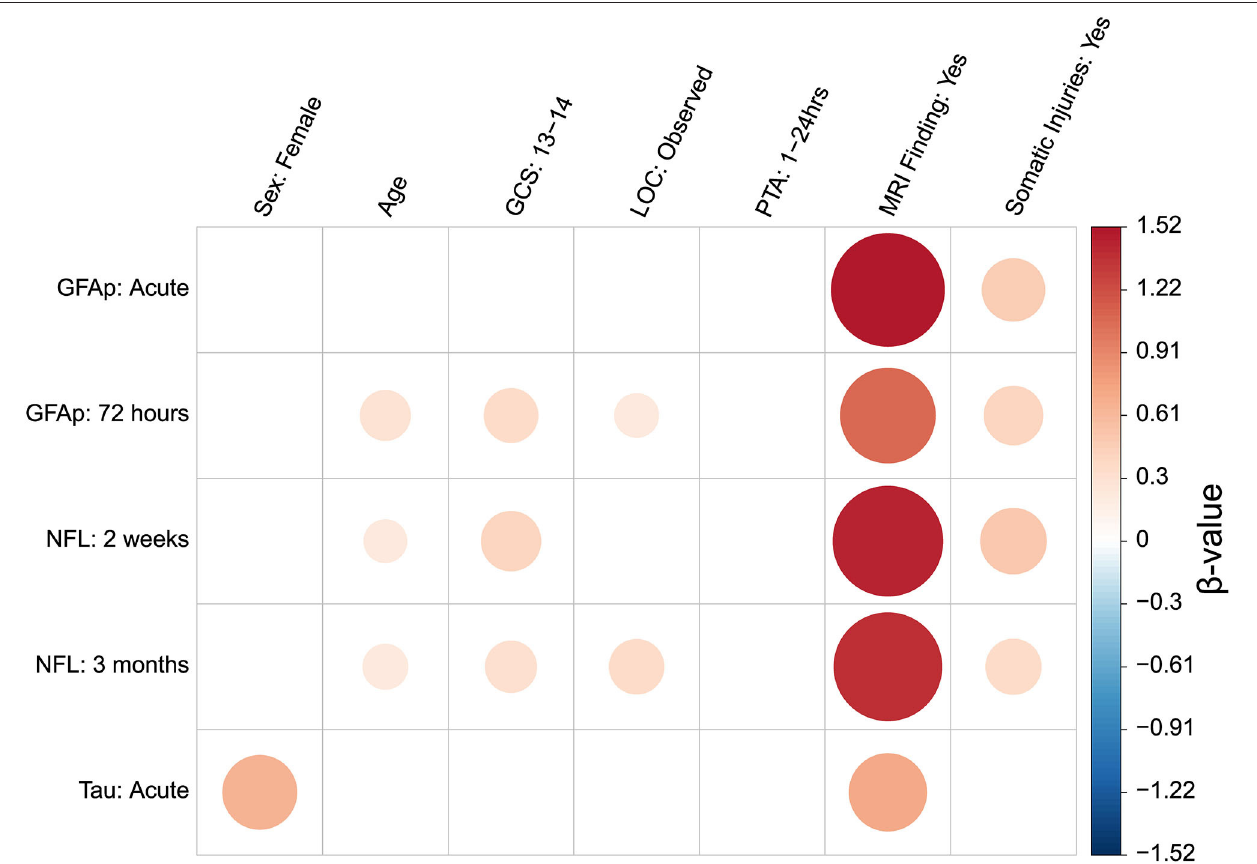
FIGURE 3 | Graphical representation of associations between biomarkers measured at selected timepoints and demographic and clinical variables. Biomarker levels at selected timepoints were input into an all-subsets multiple regression as outcome variables. Demographic and clinical variables were input as possible predictor variables. Associations shown to significantly improve model fit are depicted as colored circles. Best model fit was determined based on the Akaike Information Criterion. The direction of association is represented according to the figure legend color scheme, whereby a red color indicates a positive association and blue indicates a negative association. The size of regression coefficient is represented by both circle size and color gradient. A larger circle indicates a stronger association. Increasingly positive associations are graded to darker red, while increasingly negative associations are graded to darker blue. A blank space indicates that the predictor was not included in the final model. Associations presented by the colored circles are the beta values of the final model. The beta values are regression coefficients from models with standardized biomarker concentrations as outcome. Unstandardized beta and p -values are presented in Supplementary Table 4 . Means and standard deviations of biomarker levels separated by each categorical variable are presented in Supplementary Table 5 . GFAP, Glial fibrillary acidic protein; NFL, Neurofilament light; GCS, Glasgow coma score; LOC, Loss of consciousness; PTA, Post-traumatic Amnesia; MRI, Magnetic resonance imaging. Baseline comparison for Sex was male. Baseline comparison for GCS scores of 13–14 was GCS score of 15. Baseline comparison for LOC observed was “No LOC observed.” Baseline comparison for PTA duration of between 1 and 24h was PTA of < 1h. Baseline comparison for MRI findings was “No MRI finding.” Baseline comparison Somatic injuries was “No somatic